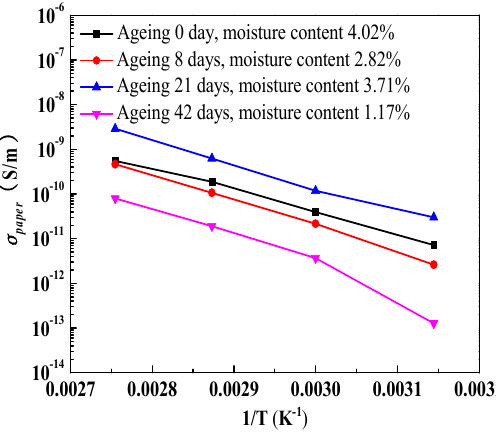
Figure 9. Variations of paper conductivity with the absolute temperature decrease.